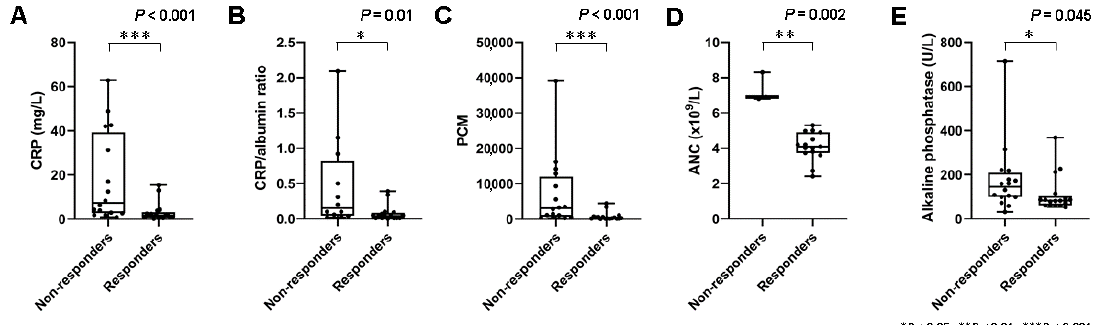
Figure 1. Markers of systemic inflammation and treatment response. ( A ) Box plots demonstrating significantly higher serum levels of C reactive protein levels (CRP) ( p < 0.001), ( B ) CRP/albumin ratio ( p = 0.01), ( C ) platelet × CRP multiplier (PCM) ( p < 0.001), and ( D ) absolute neutrophile count (ANC) ( p = 0.002) in non-responders. ( E ) Serum levels of alkaline phosphatase (ALP) ( p = 0.045) were also associated with response, albeit less clearly. Table 2. Assessment of prognostic value of blood-based parameters for response